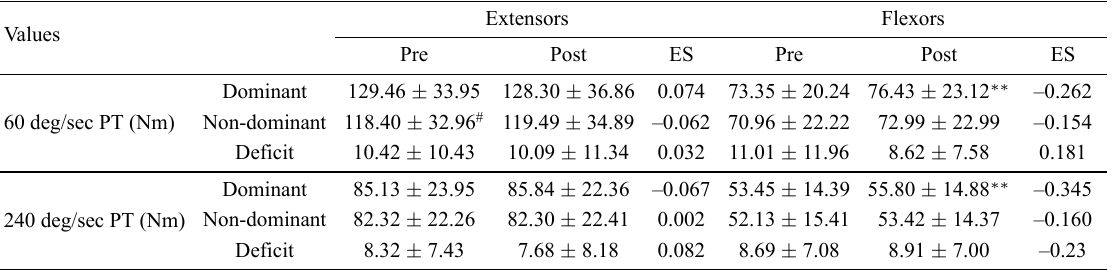
Table 3. Absolute values of isokinetic peak torque, total work, average power, and endurance ratio on extensors and flexors of knee joint for middle school soccer players (MSP).